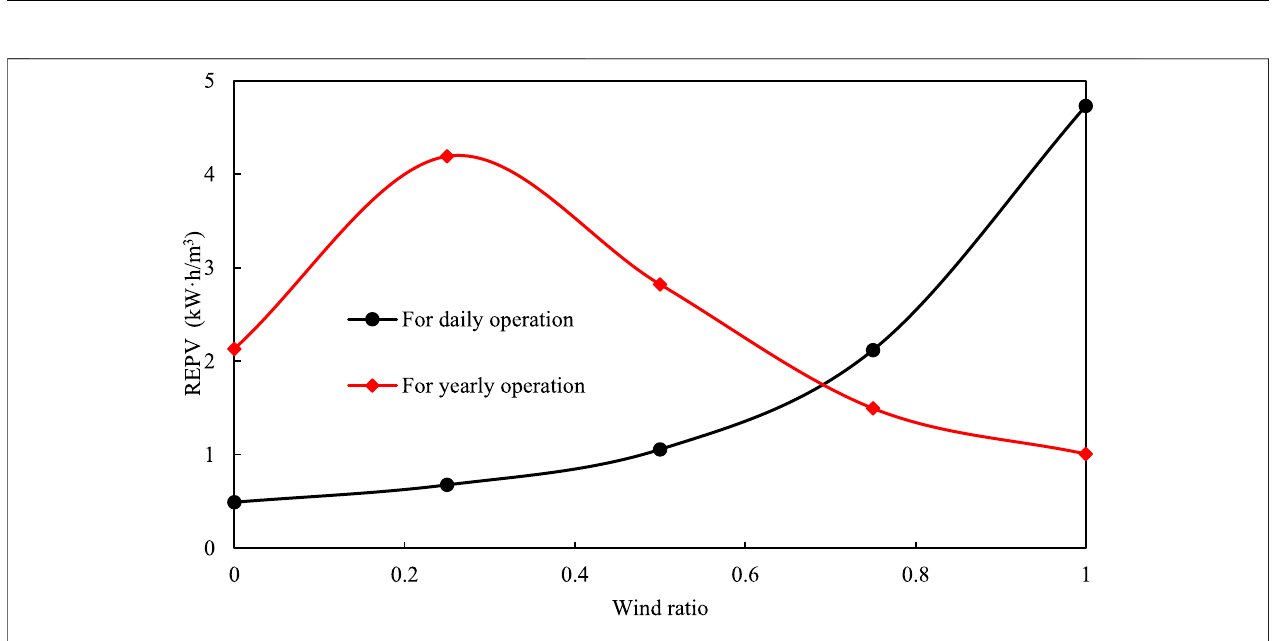
FIGURE 12 | Average component output and water volume variation over 12 months when α w (cid:2) 0 . 74.